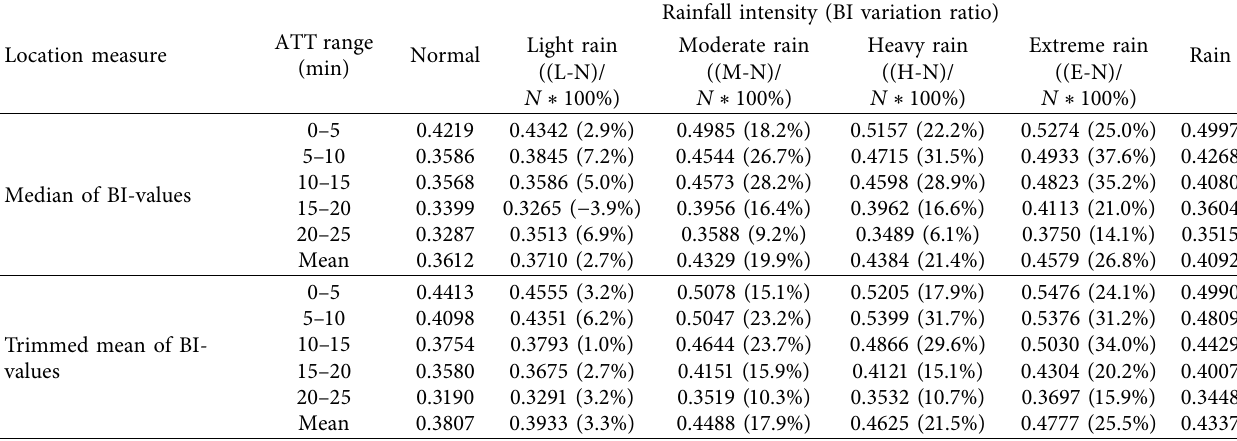
Location measure